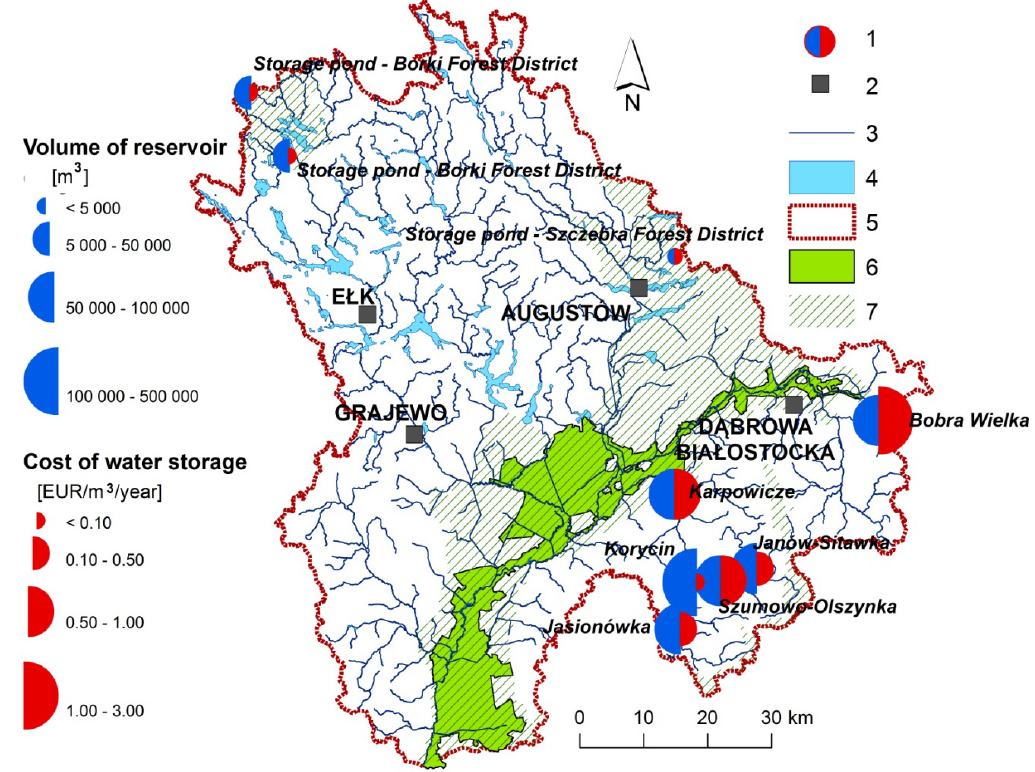
Figure 6. Location, volume, and design/construction costs of selected water storage investments, undertaken in years 2000–2012 within the catchment of the Biebrza River. Calculated unit cost of water storage is given by each location. 1 storage ponds; 2 major towns; 3 rivers and canals; 4 lakes; 5 watershed of the Biebrza catchment; 6 boundaries of the Biebrza National Park; 7 Natura 2000